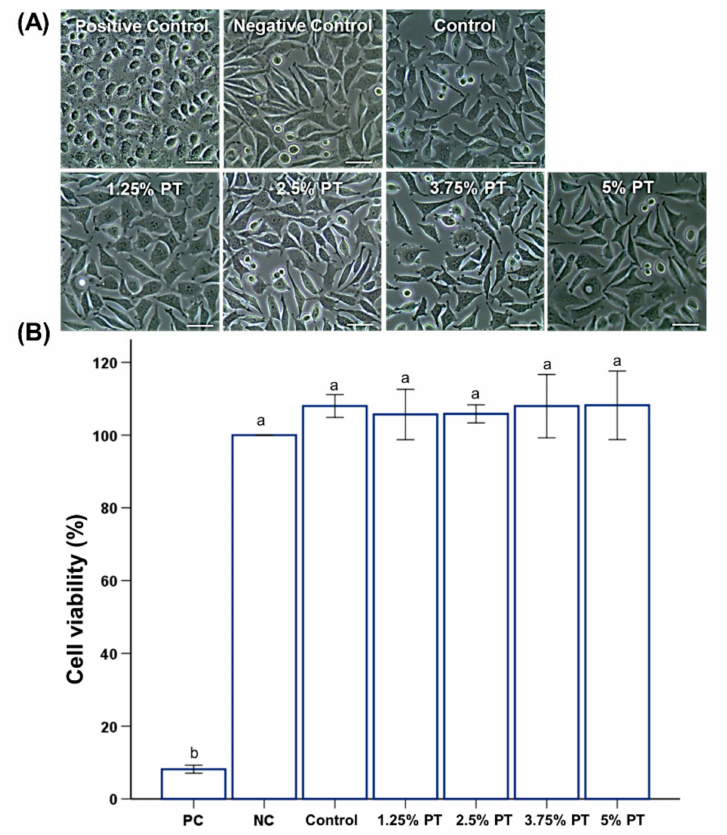
Figure 4. Representative microscopic images of L929 cells on the surfaces of PMMA samples; control, 1.25% PT, 2.5% PT, 3.75% PT and 5% PT at a magnification of 20 × ( A ), comparison of cell viability among di ff erent groups of PMMA samples ( B ). Same lowercase alphabetical letters above the bar graph indicate there are no significant di ff erences between the groups (e.g., there are no di ff erences between group with ‘a’ and another group with ‘a’ above the bar) ( p > 0.05). Di ff erences in lowercase alphabetical letters above the bar graph indicate significant di ff erences between the groups (e.g., there are di ff erences between the group with ‘a’ and the group with ‘b’.) ( p <